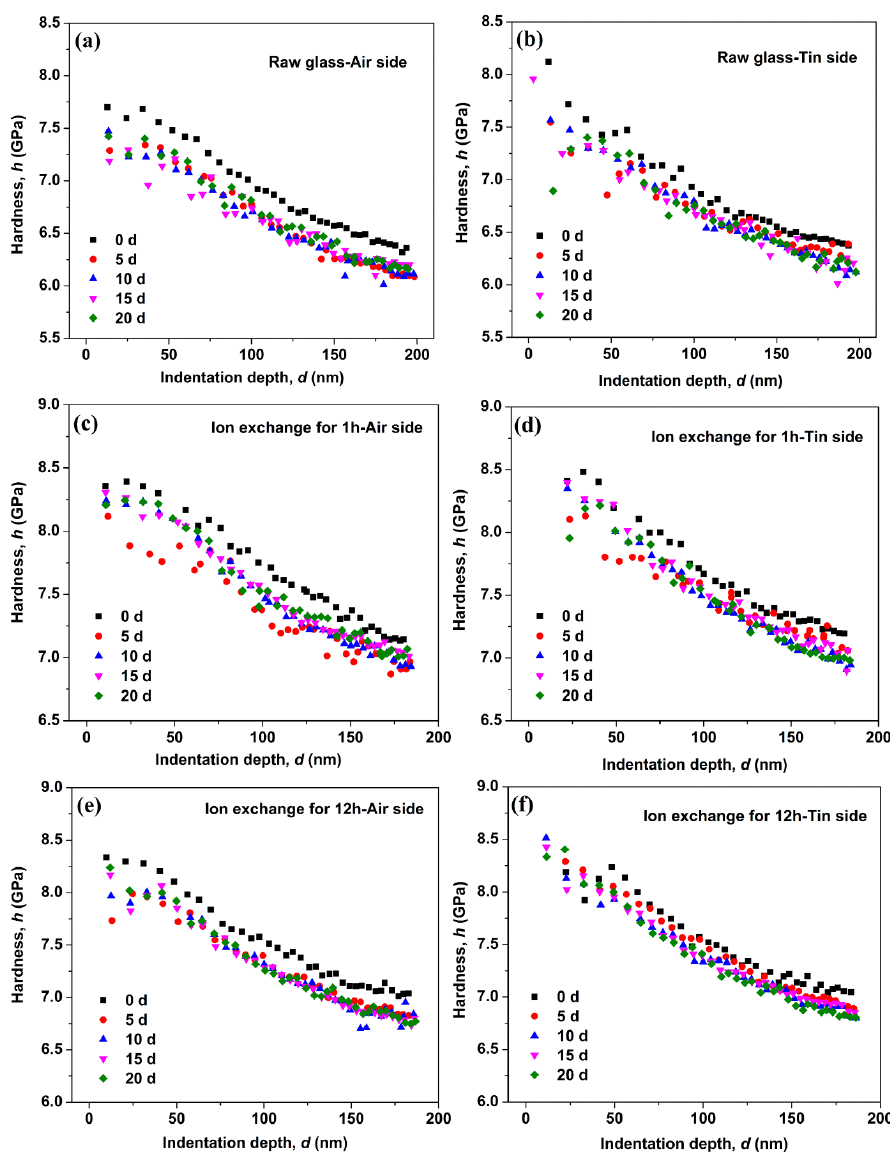
Figure 2. Hardness as a function of the indentation depth on the air side of the raw glass ( a ), on the tin side of the raw glass ( b ), on the air side of the ion-exchanged glasses for 1 h ( c ), on the tin side of the ion-exchanged glasses for 1 h ( d ), on the air side of the ion-exchanged glasses for 12 h ( e ) and on the tin side of the ion-exchanged glasses for 12 h ( f ).